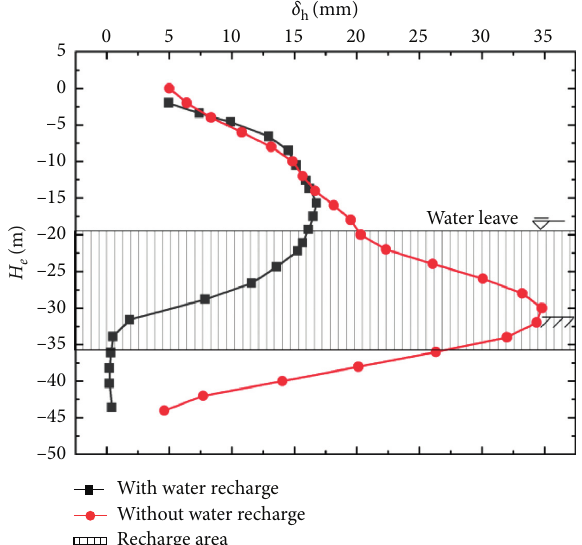
Figure 14: δ H h versus e for water recharge and without water